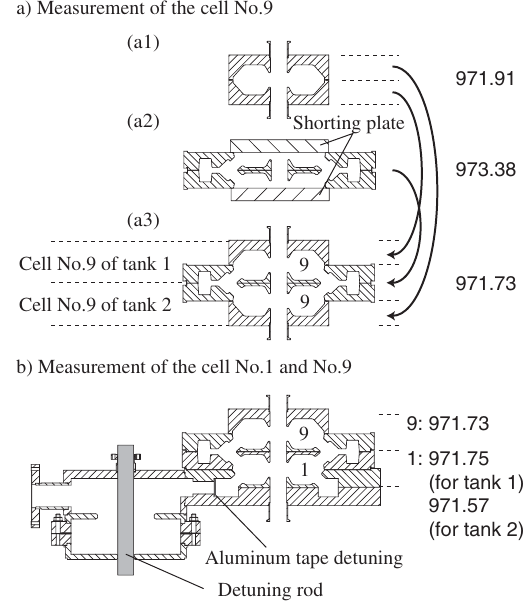
FIG. 15. Measurement setup for the end cells (no. 1 and no. 9). The cell numbering is shown in Figs. 6(a) and 7(a). (a) Measurement procedure for the two no. 9 cells. (b) Cell no. 1 and no. 9 are stacked to measure their frequencies. Only the average value was measured.